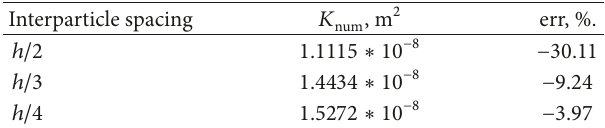
Table 3: The calculated permeability 𝐾 spheres for 𝜙 = 0.343 , 𝐿 = 20ℎ with refined